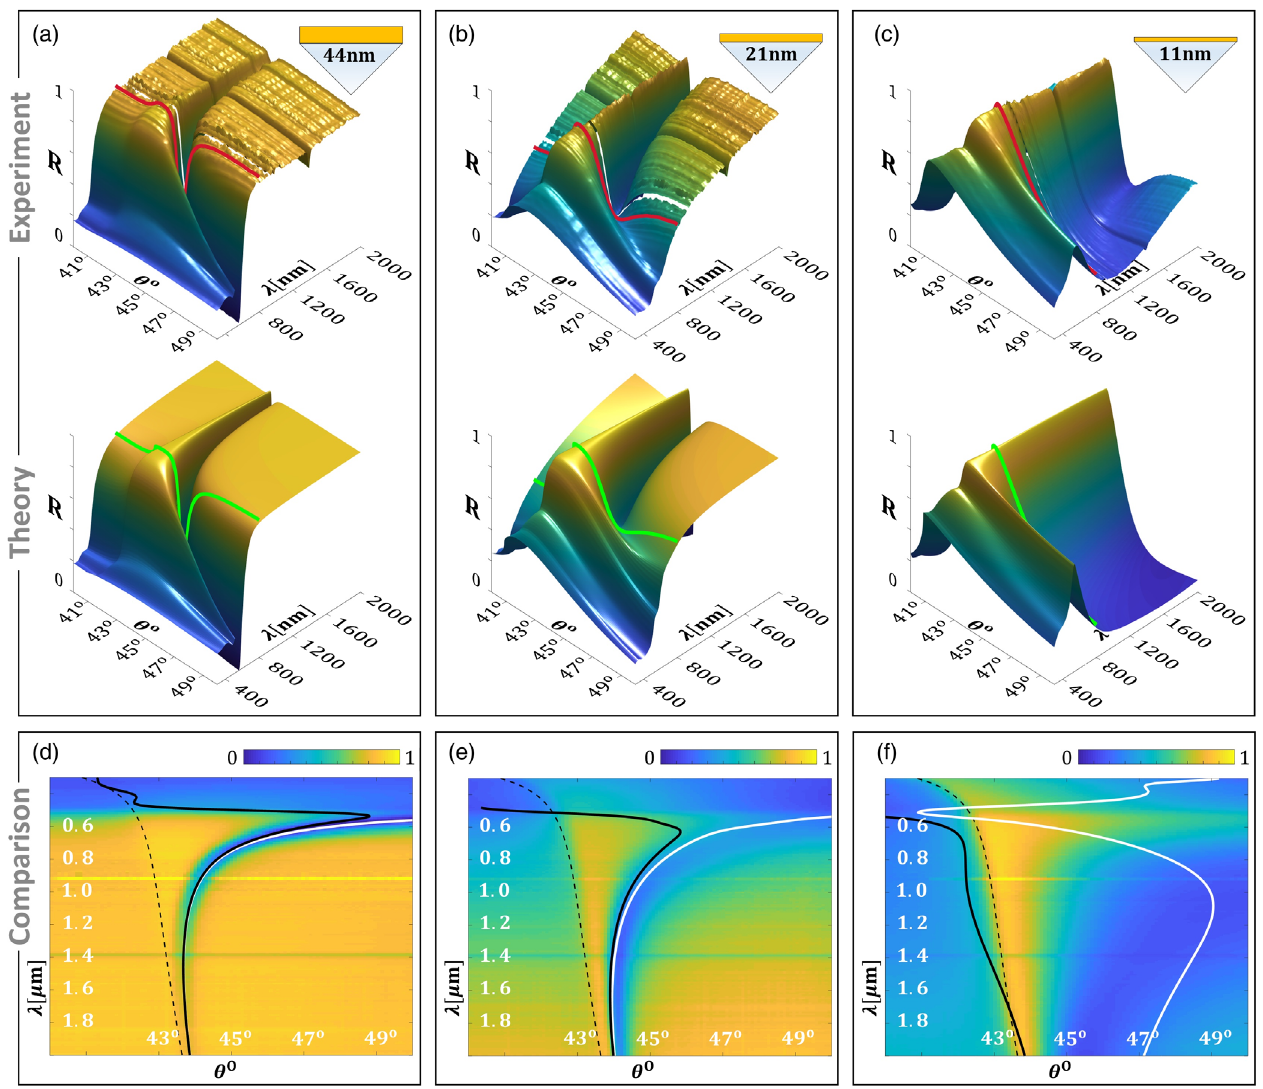
FIG. 3. Experimental results: excitations of APP and SPP degrees of freedom in thin gold films. (a) – (c) Measured (top) and predicted (bottom) reflectance from a (a) 44, (b) 21, and (c) 11 nm thin gold film fabricated atop a glass coupling prism as a function of incidence angle θ and illumination wavelength λ , also shown in Movie 3. (d) – (f) Calculated real part of the long-range SPP (black) and APP (white) dispersion curves overlaid atop the measured reflectance for each film. Dashed black lines denote the critical angle. Red and green curves in (a) – (c) highlight the measured and predicted reflectance at λ ¼ 800 nm analyzed in Fig. 4. The offset between regions of high and low reflectance and the black and white curves in (f) is explained in Appendix B [Fig. 1(b), red curve]: a pronounced zero-reflectance dip at an above-critical angle over a total internal reflection background, known as the Kretschmann dip [26,27,43].